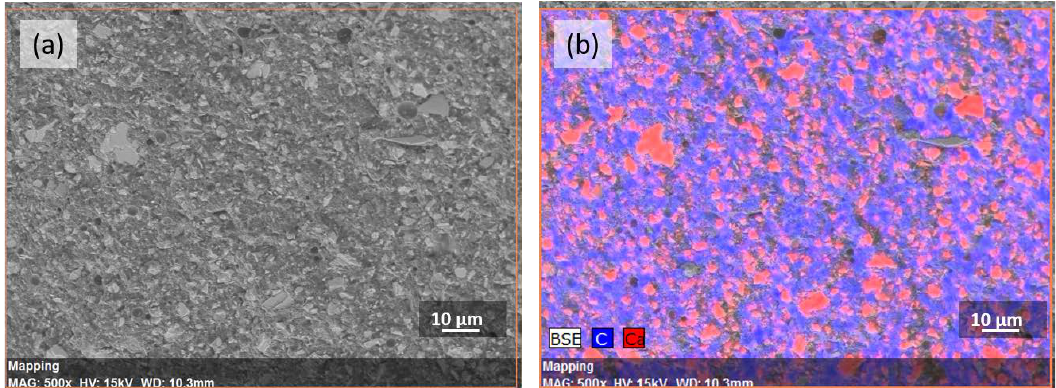
Figure 7. SEM image ( a ) and the corresponding EDX (Energy-dispersive X-ray spectroscopy) mapping image ( b ) of the elements C and Ca. The colours blue and red indicate the distribution of carbon and calcium in the sample, respectively.